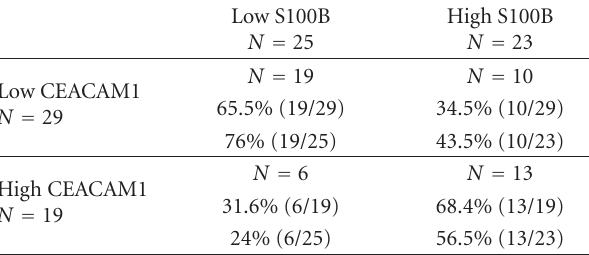
Table 2: sCEACAM1 correlates with S100B. ELISA measurements of posttreatment sCEACACM1 and S100B yielded values that were divided relative to median levels into “low” and “high.” The correlations between the two resulted “low” subgroups, as well as between the two “high” subgroups, were tested and found to be significant ( P = 0 . 02). Percentages in each cubical refer to sCEACACM1 (first row) or to S100B (second row). Low S100B N = 25